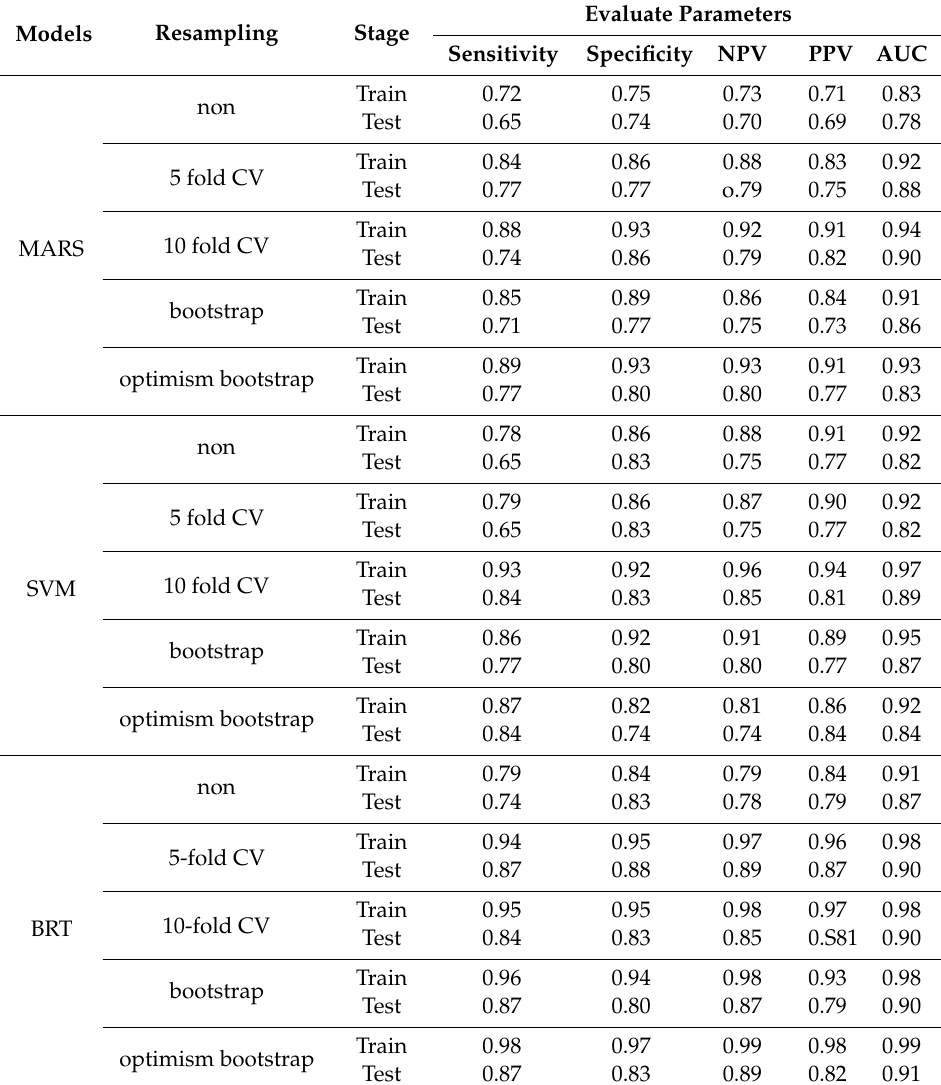
Table 3. Predictive capability of forest fire models using train and test dataset.